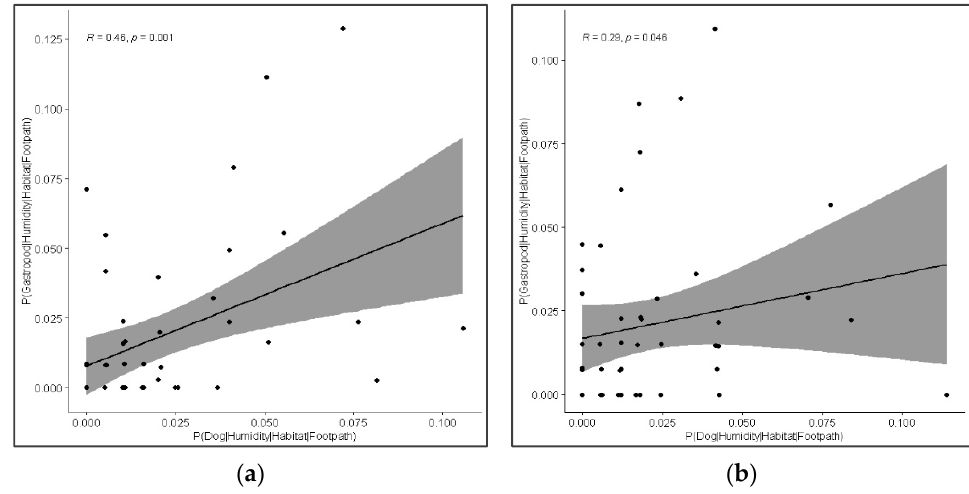
Figure 6. Correlation between conditional probabilities for dogs ( Canis lupus familiaris ) and for gastropods (mollusca) during the; ( a ) morning, and ( b ) day, where all other conditions were matched. Data were derived from quadrat and point count transect data across 7 study sites in Brighton and Hove and surrounding areas, England, UK.